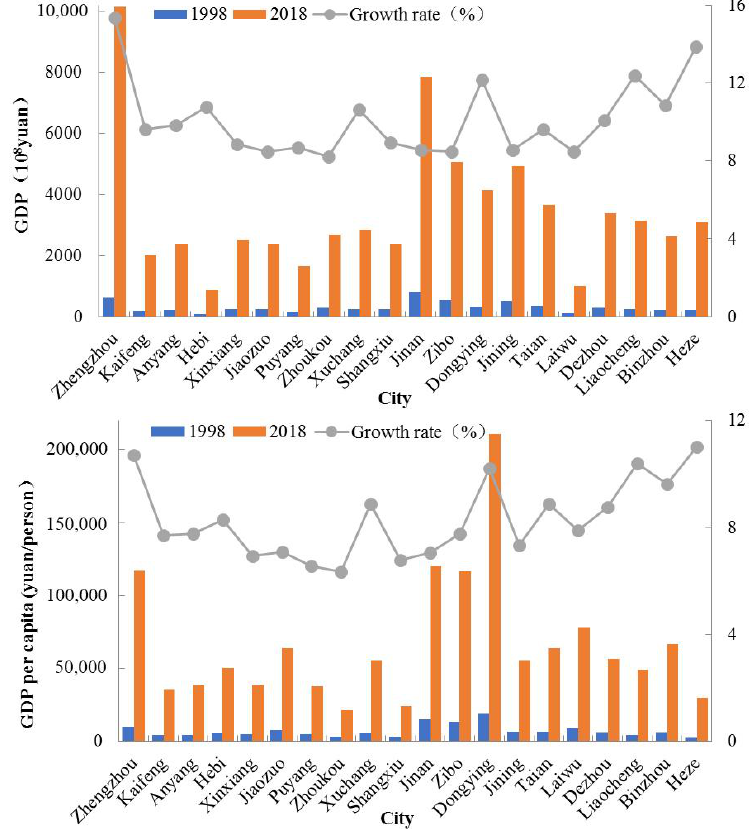
Figure 4. Economic development of the cities in the AALYR.